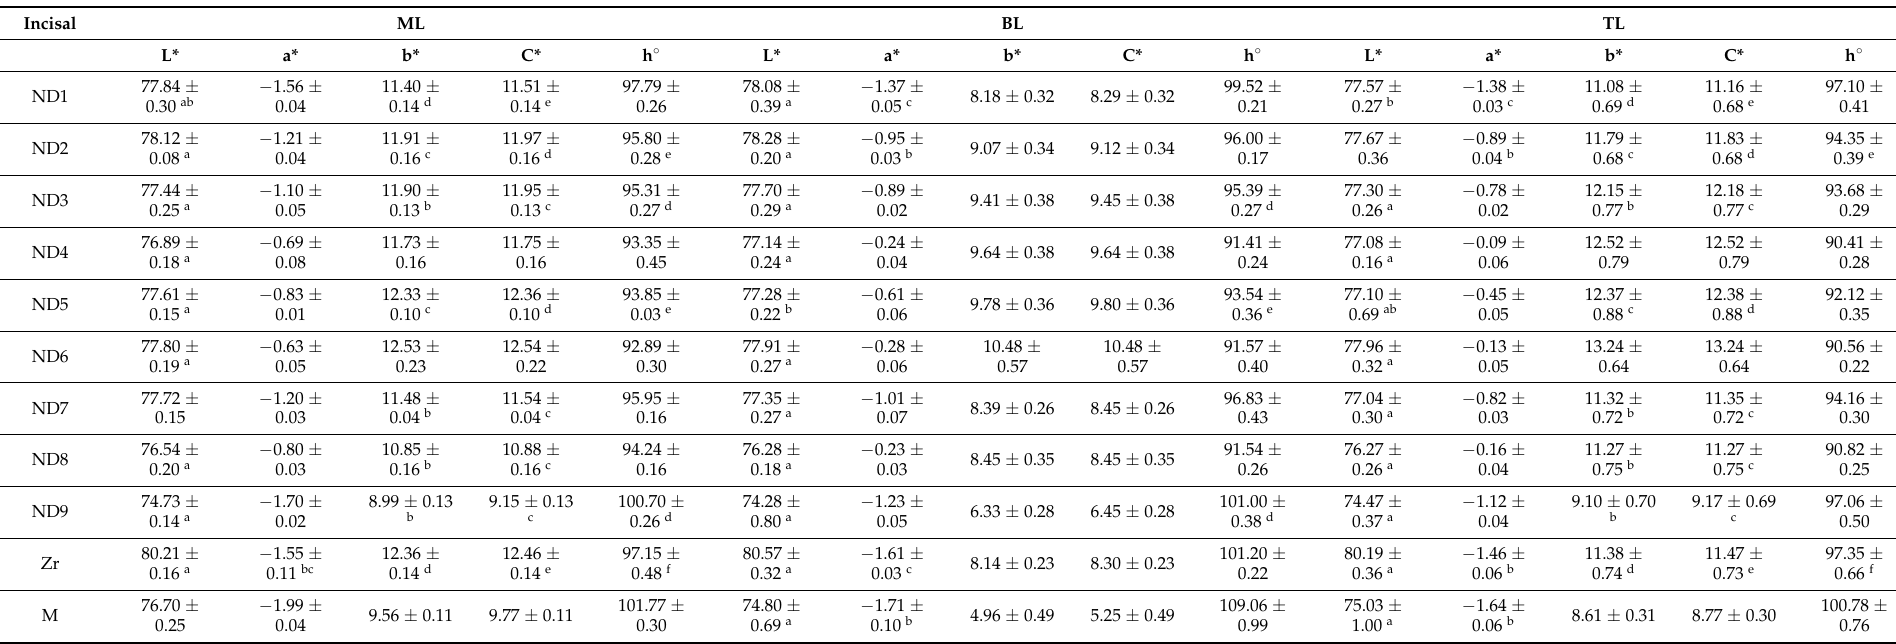
Table 3. Mean values and standard deviation of CIE L*, a*, b*, C*, and h ◦ color coordinates of zirconia crowns on different substrates evaluated for the incisal